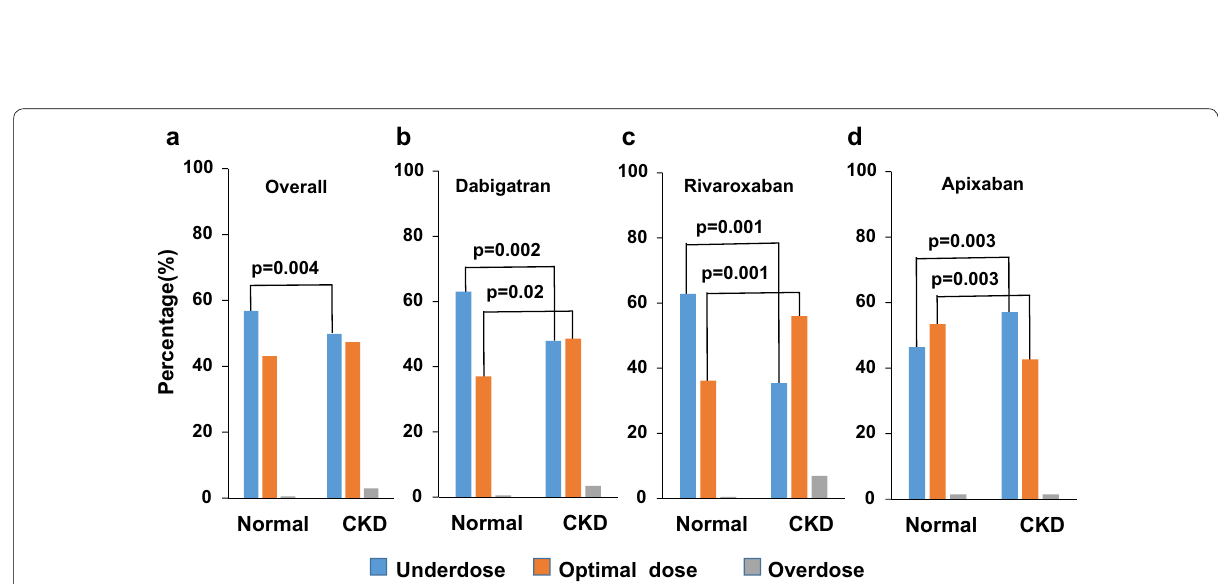
0.001). c Comparison of NOAC in each =